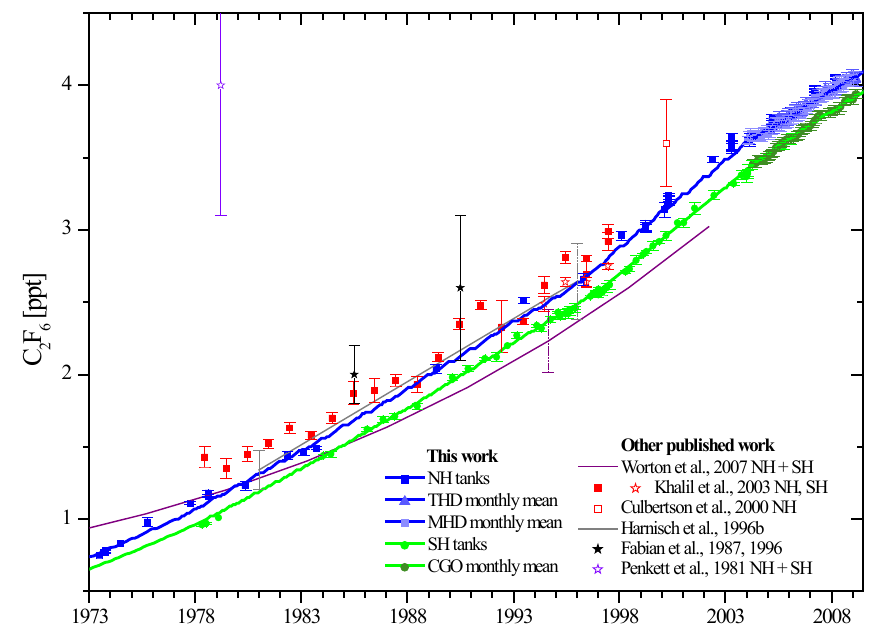
Fig. 2. AGAGE C 2 F 6 abundances from archived Northern Hemisphere (NH) and Southern Hemisphere (SH) air samples and in situ mea- surements at Mace Head, Ireland (NH), Trinidad Head, California (NH) and Cape Grim, Tasmania (SH) and modeled 30–90 ◦ N and 30–90 ◦ S abundances all shown on the SIO-2007 calibration scale compared to previous observations. Uncertainty estimates for the MPAE 86 and UEA scales are indicated as additional dashed error bars. For the SIO-2007 scale they are is similar to the shown measurement precisions ( ∼ 1–2%).